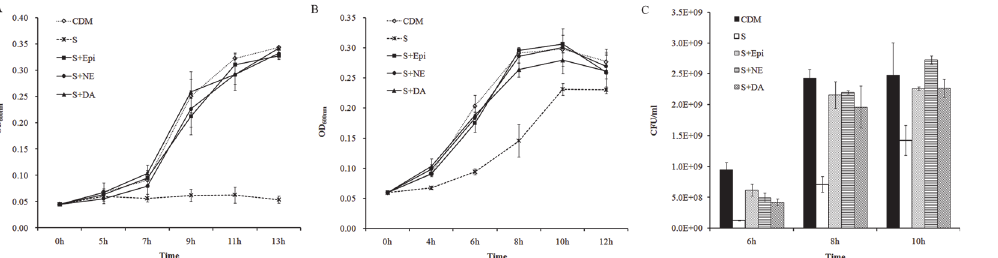
Fig 2. Catecholamine induced A . pleuropneumoniae growth in CDM containing serum. A . pleuropneumoniae was cultured in TSB medium overnight and then sub-cultured into CDM containing 1/40 of serum (S) using an inoculation dose of 10 4 CFU/ml (A) or 10 6 CFU/ml (BC) . Epi, NE and DA at 50 μ M were supplemented into the serum-containing medium (S + Epi/NE/DA). A . pleuropneumoniae cultured in CDM without any supplementation was used as control (CDM). Optical densities of bacterial cultures (OD 600nm ) were recorded at selected time points (AB) . Bacterial viable numbers were recorded after sub- culturing using 10 6 CFU/ml at 6 h, 8h and 10h, respectively (C) . Data are shown as means ± SD from four independent